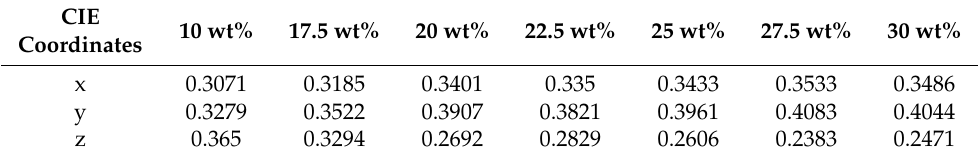
Figure 7. Effects of the concentration of phosphor particles, spectra of ( a ) CPCs and ( b ) ATFPCs; ( c ) luminous flux and relative increase in ATFPCs; ( d ) the CCT of ATFPCs and CPCs. Table 2. CIE coordinates verse phosphor concentration of